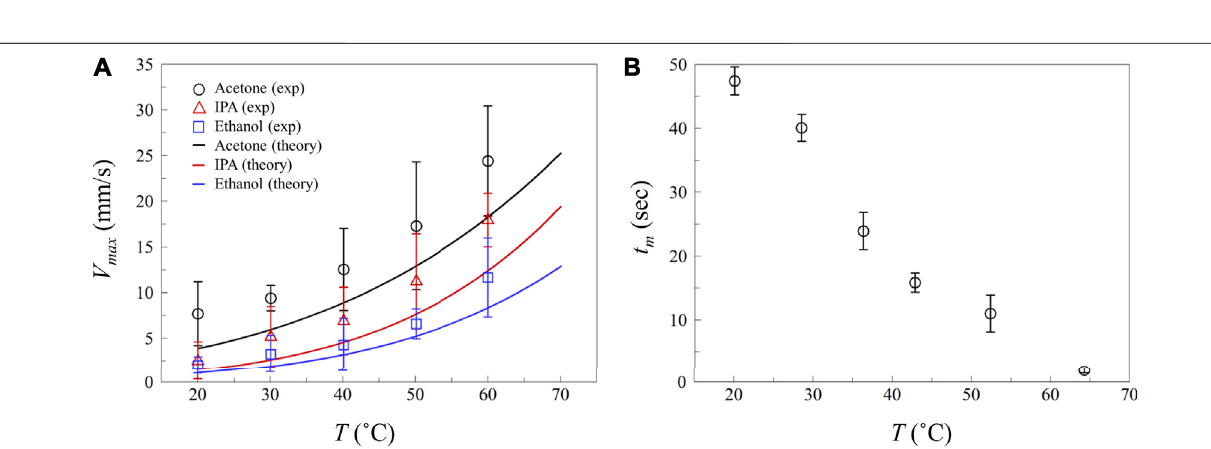
FIGURE 4 | PIV results for the vapor-mediated solutal Marangoni fl ow fi elds at varying temperatures of the volatile liquid.